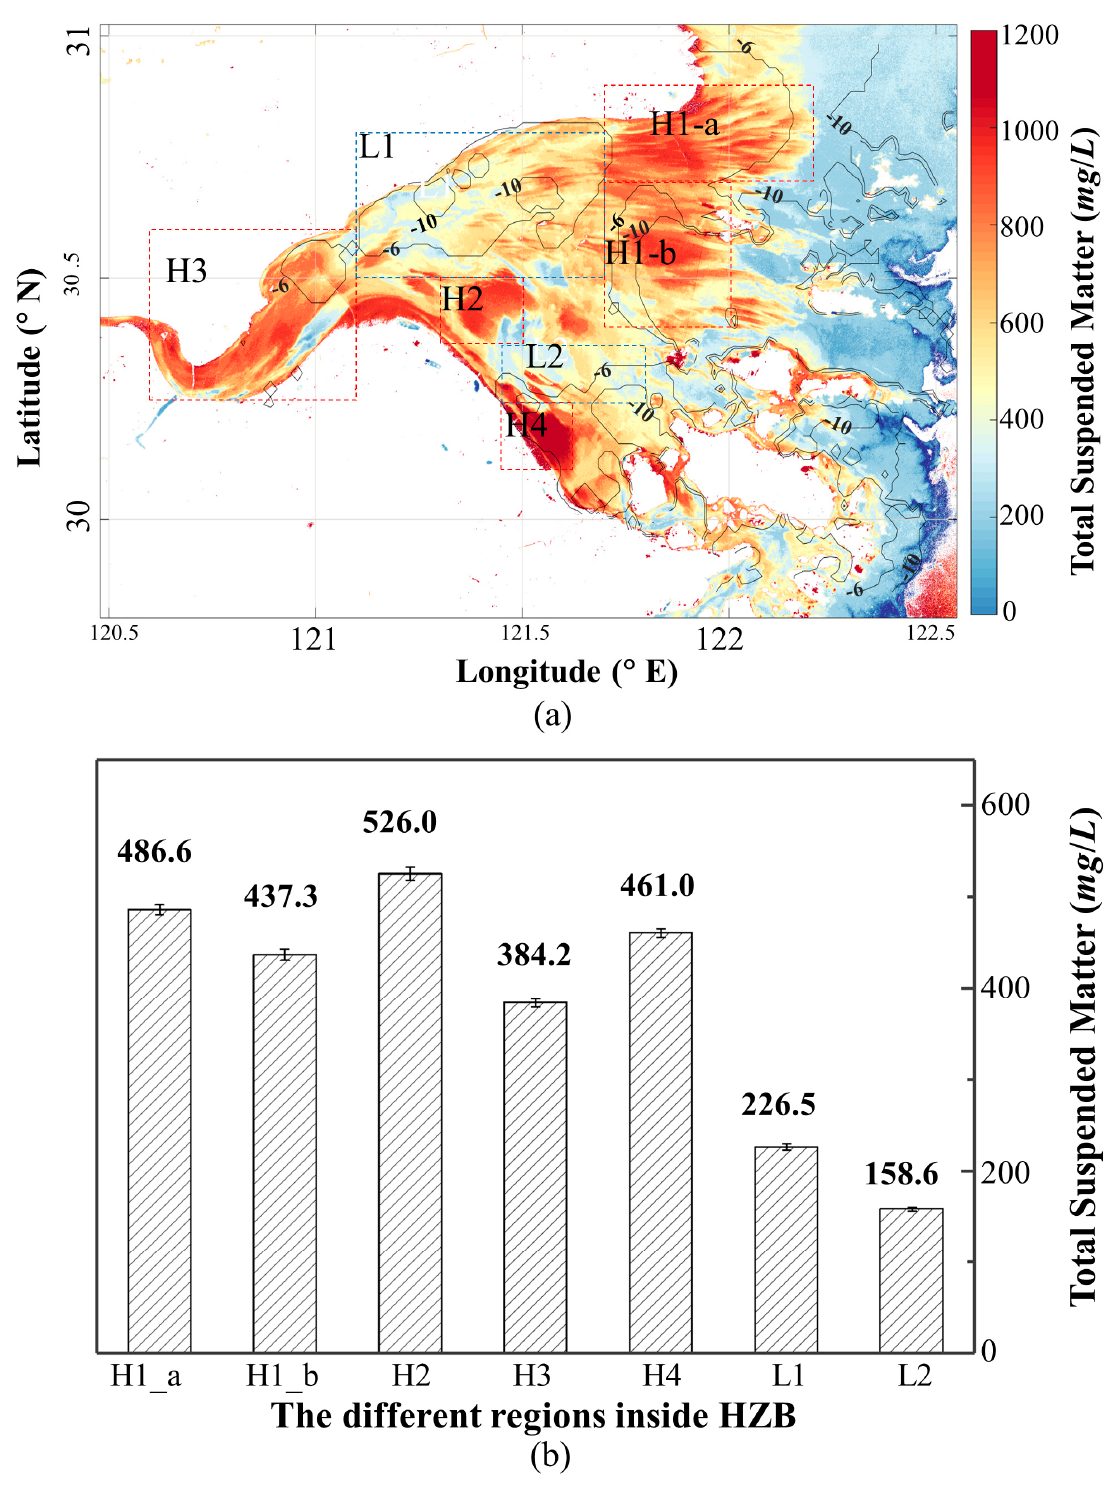
Figure 4. The spatial distribution of mean TSM concentration during the study period in HZB. ( a ) The bathymetry contours of HZB shown in the TSM concentration distribution image. ( b ) The mean TSM concentration of different regions inside HZB, including four high TSM concentration zones and two low TSM concentration zones (H1_a from 121.70 to 122.20 ◦ E and 30.70 to 30.90 ◦ N, H1_b from 121.70 to 122.00 ◦ E and 30.40 to 30.70 ◦ N, H2 from 121.30 to 121.50 ◦ E and 30.35 to 30.50 ◦ N, H3 from 120.60 to 121.10 ◦ E and 30.25 to 30.60 ◦ N, H4 from 121.45 to 121.60 ◦ E and 30.10 to 30.25 ◦ N, L1 from 121.10 to 121.70 ◦ E and 30.50 to 30.80 ◦ N, and L2 from 121.45 to 121.70 ◦ E and 30.25 to 30.35 ◦